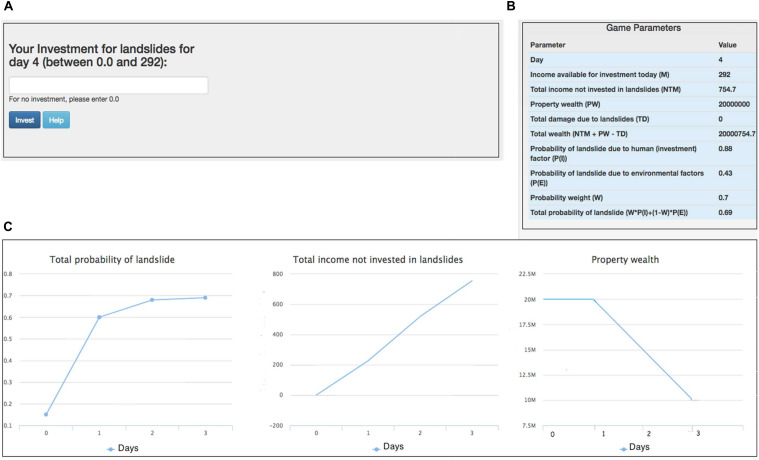
The Investment Screen in ILS tool. (A) The text box where participants made investments against landslides. (B) The tool’s different parameters and their values. (C) Line graphs showing the total probability of landslide, the total income not invested in landslides, and the property wealth over days. Horizontal axes in these graphs represents number of days. The goal was to maximize the Total Wealth across a number of rounds of performance in the ILS tool. This figure is adapted from Chaturvedi et al. (2017).